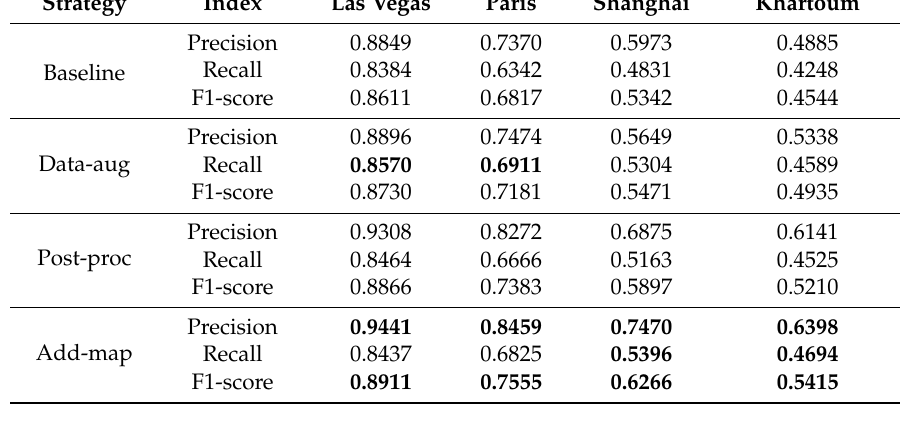
Table 7. Results obtained after applying different strategies of our proposed method.